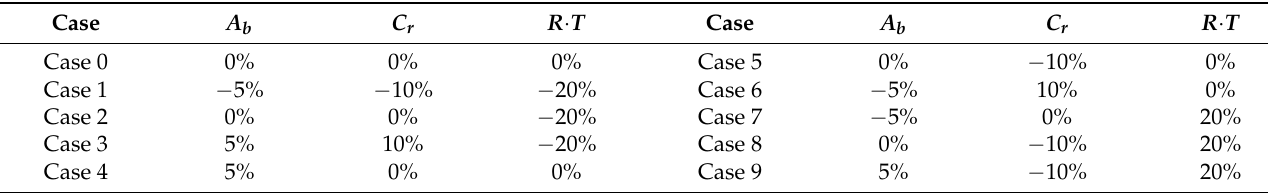
Table 4. The perturbation of model parameters.